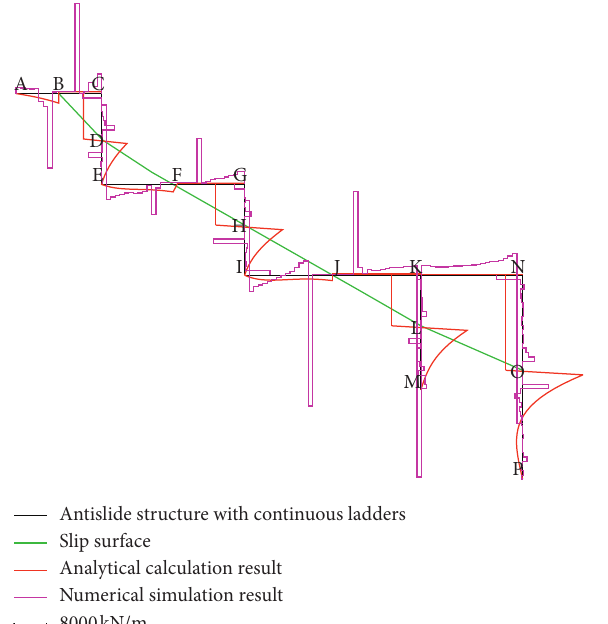
Figure 17: A comparative figure of the interaction between the antislide members and geotechnical materials. The black lines represent the initial shape of the ASCL, and the green lines represent the slip surface. Taking the initial shape of the ASCL as a standard, the red lines represent the interaction between the antislide members and geotechnical materials of the analytical calculations, while the pink lines represent the interaction between the antislide members and geotechnical materials of the numerical calculations.